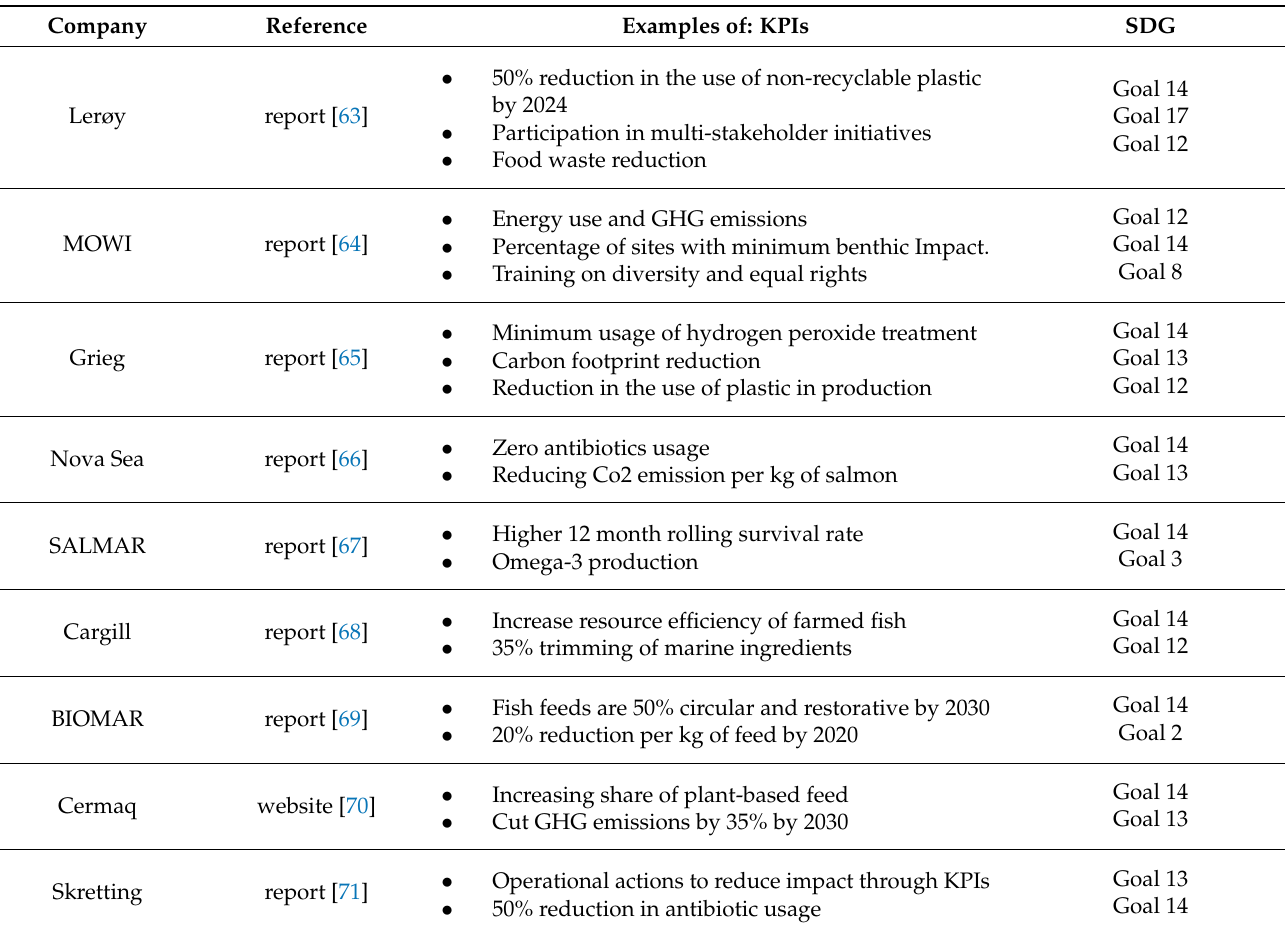
Table 6. Examples of KPIs derived from SDGs found in the reviewed